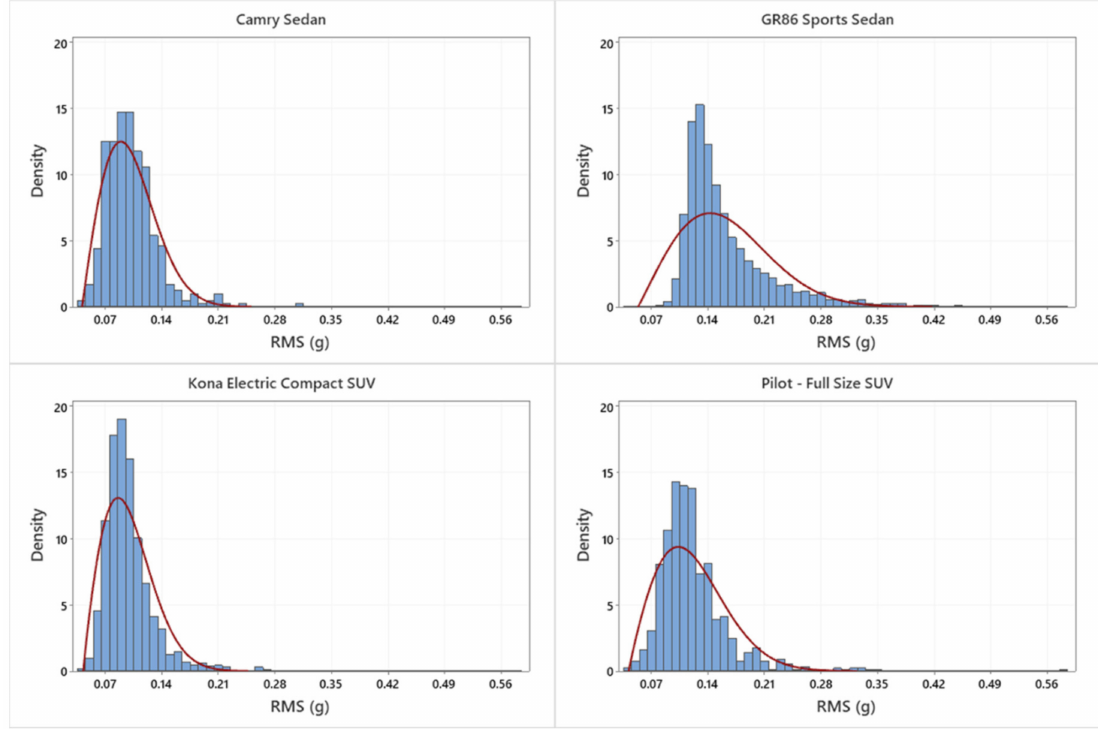
Figure 10. RMS distribution of vehicles in the vertical